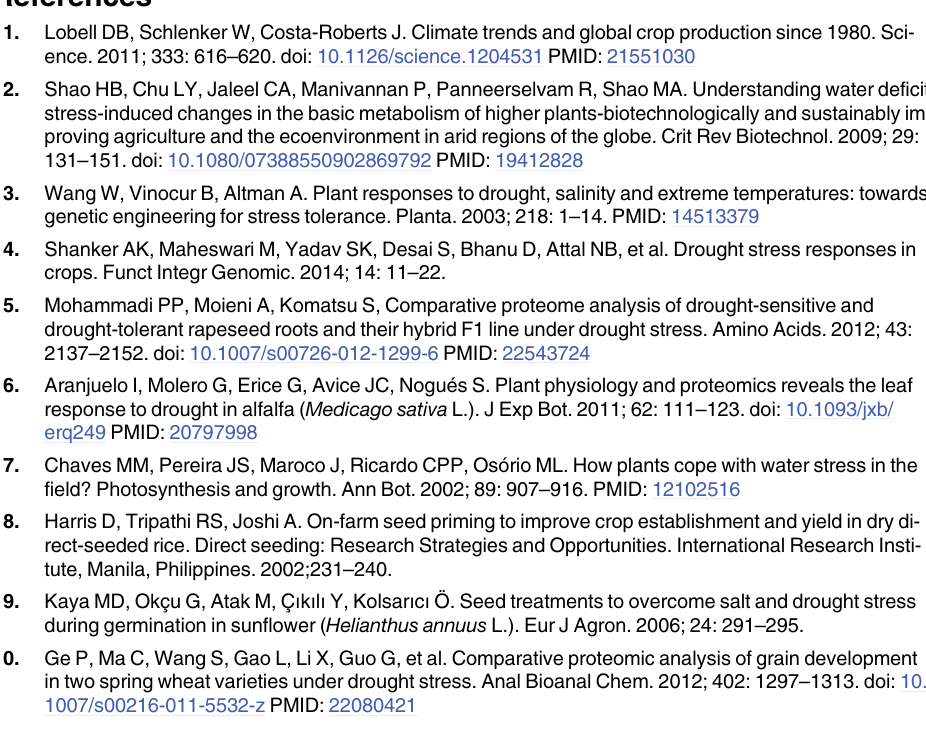
S1 Table. Complete list of 101 differentially accumulated proteins in NC47 and CS seedling leaves. a) Spot number as given in Fig 2. b) Accession number: according to the NCBI database. c) Protein Score: statistical probability of true positive identification of the predicted protein calculated by MASCOT with 0.3 peptide tolerance and one allowed missed cleavage. d) Protein Score C.I.%: the PMF score percentage of protein sequence (Confidence interval: Protein Score